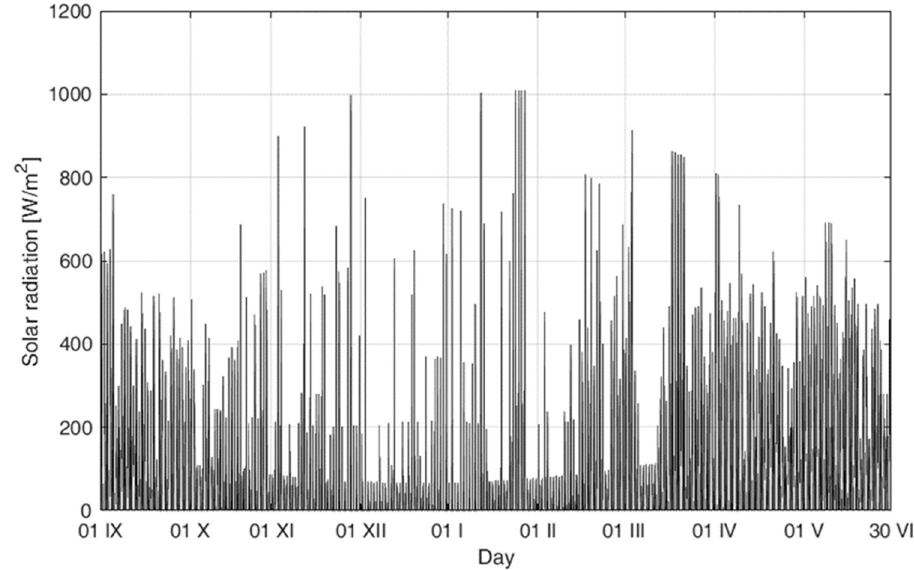
Figure 3. The intensity of solar radiation falling on the vertical plane in Pozna ń during the heating period.